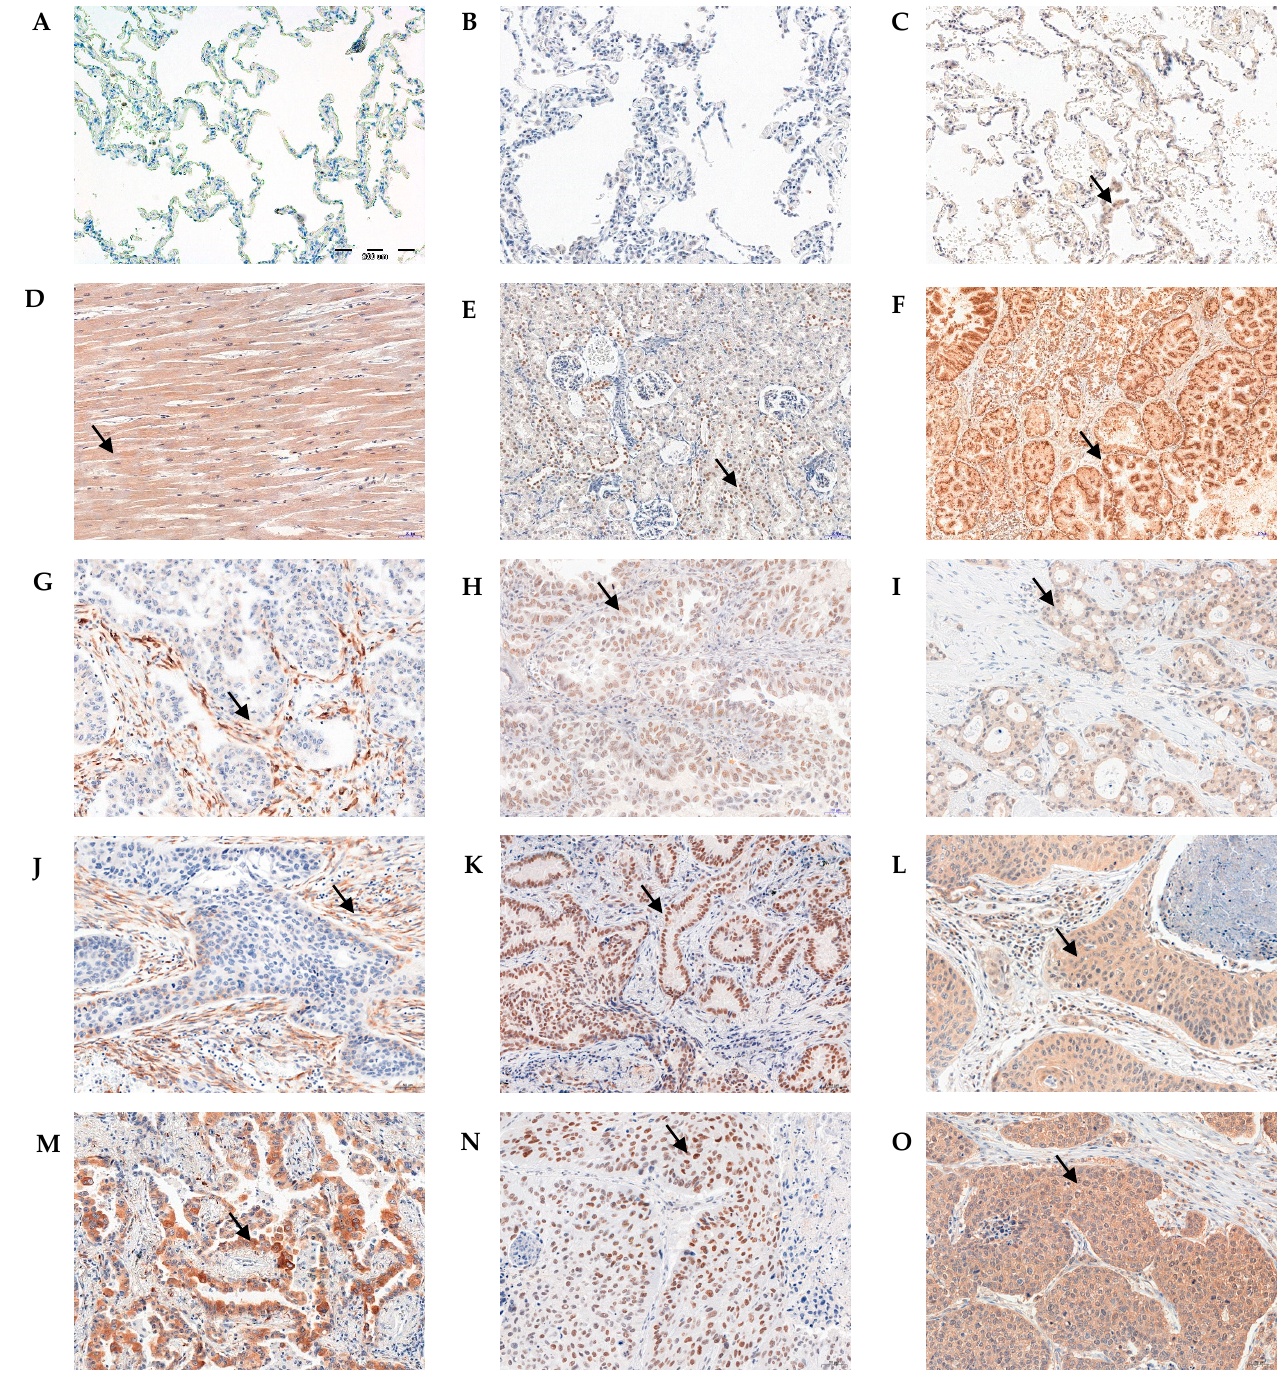
Figure 1. Immunohistochemical reactions (IHC) indicating lack of irisin ( A ) and ERR α ( B ) expres- sion. Weak positive IHC reaction for PGC-1 α ( C ) in non-malignant lung tissue (NMLT). Positive cytoplasmic IHC reaction indicating irisin expression in skeletal muscle (positive control— D ). Irisin expression in NSCLC cancer cells and stromal cells (grade of malignancy G1— G , G2— J , G3— M ). Nuclear expression of ERR α in kidney (positive control— E ). ERR α expression in NSCLC cancer cells (G1— H , G2— K , G3— N ). Positive cytoplasmic expression of PGC-1 α in prostate (posi- tive control— F ). PGC-1 α in NSCLC cancer cells and stromal cells (G1— I , G2— L , G3— O ). Magni- fication ×200. Arrows indicate a positive reaction.